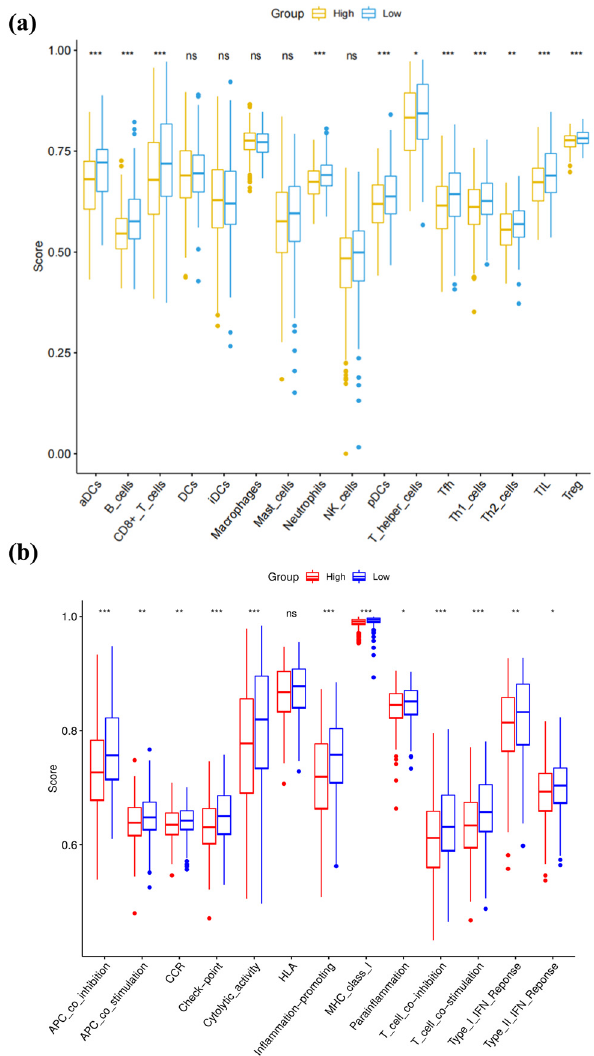
Figure 4: Analysis of immune in fi ltration of tumor cells. ( a ) Comparison of the ssGSEA scores for immune cells ( high - risk group: red box and low - risk group: green box ) . ( b ) Comparison of the ssGSEA scores for immune pathways ( high - risk group: red box and low - risk group: blue box )